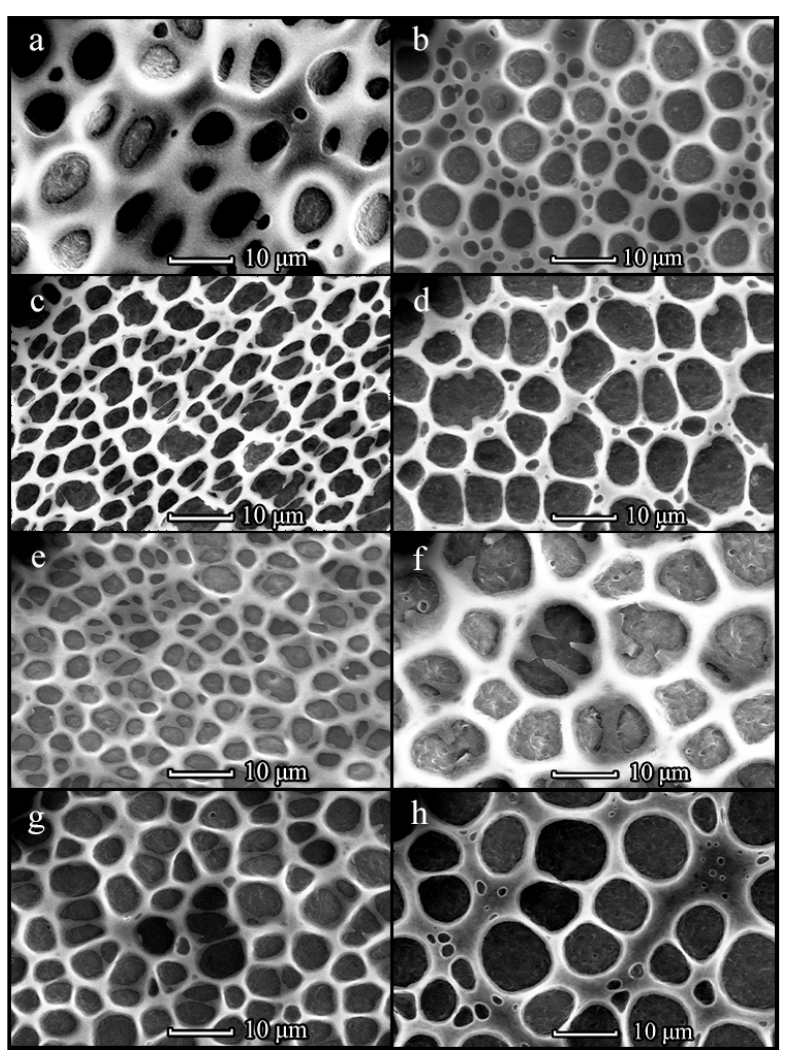
Figure 6. SEM-images of the PHB350 ( a , b ), PHB1800 ( c , d ), PHB- co -HV(9%) ( e , f ) and PHB- co -HV(17%) ( g , h ) films obtained from solution with concentrations of, 20 mg/mL upon L = 1 cm ( a , c , e , g ) and L = 3 ( b , d , f , h ). The solution volume is 150 μ L.